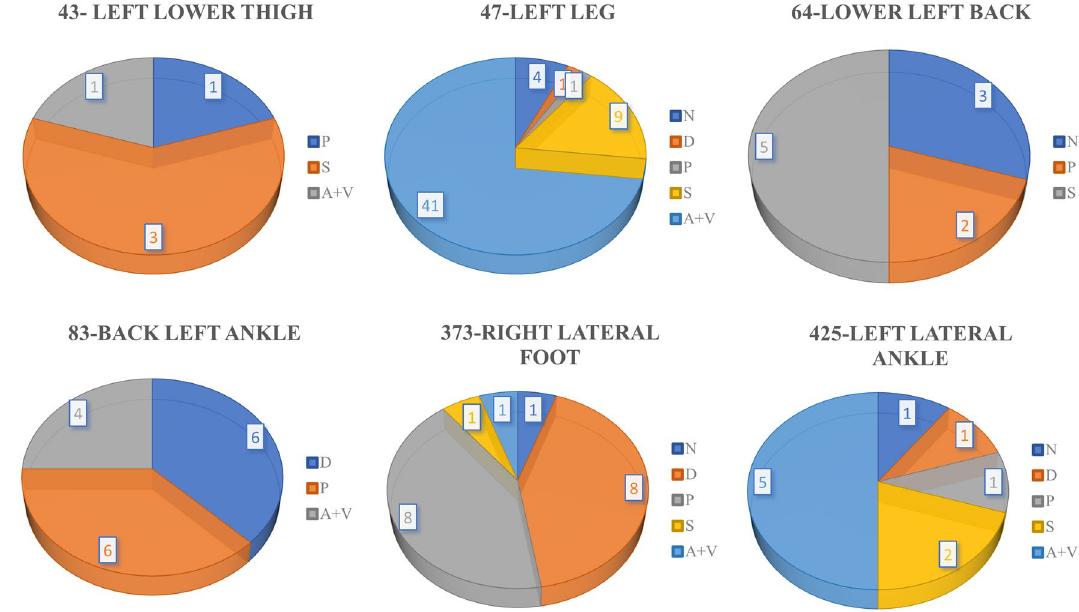
Figure 9. Examples of location overlaps on AZHMT